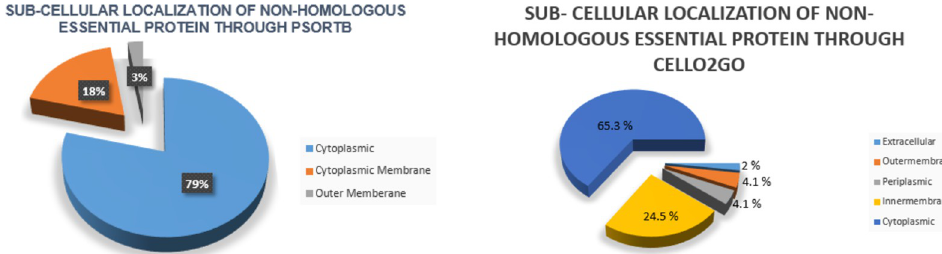
Fig 2. Subcellular localization: (A) Psortb results showing the subcellular distribution of 38 essential proteins identified in M . catarrhalis (B) CELLO2GO results showing the subcellular distribution of 38 essential proteins identified in M . catarrhalis